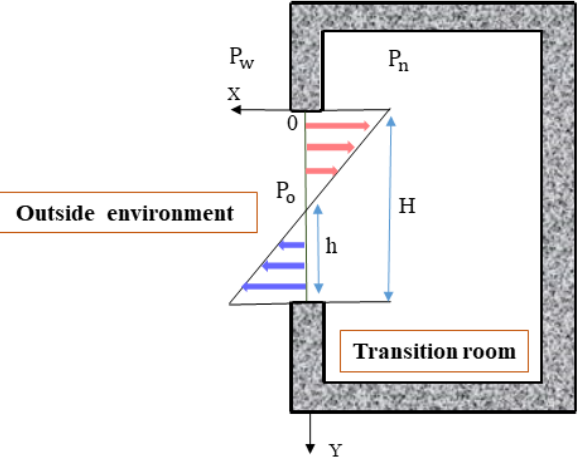
Figure 5. Hot pressure distribution diagram.